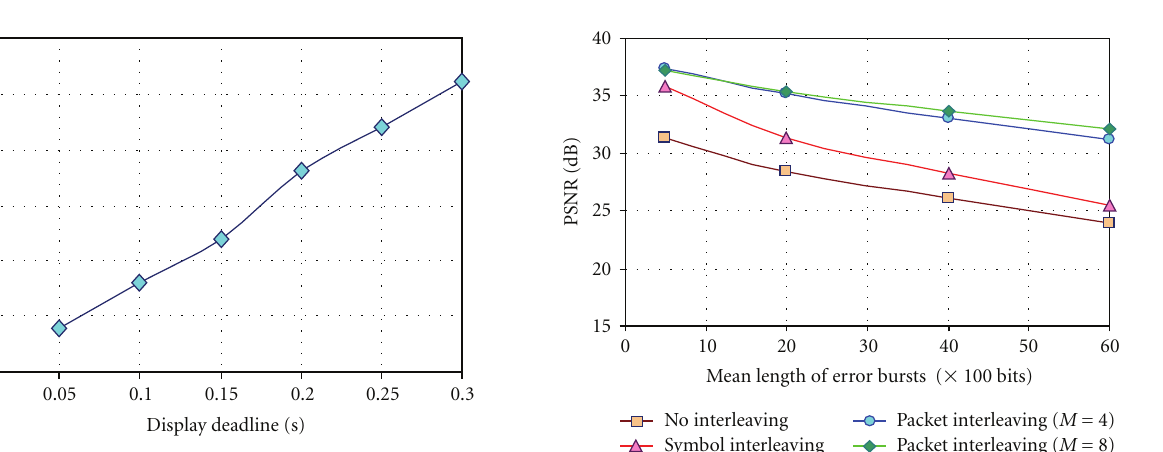
Figure 8: Video quality after streaming the News video across a Bluetooth channel with the basic FEC interleaving scheme for two global FEC group sizes. “No Interleaving” includes built- in Bluetooth FEC, while “Symbol Interleaving” also includes bit interleaving within blocks. Both the latter schemes are at the subpacket